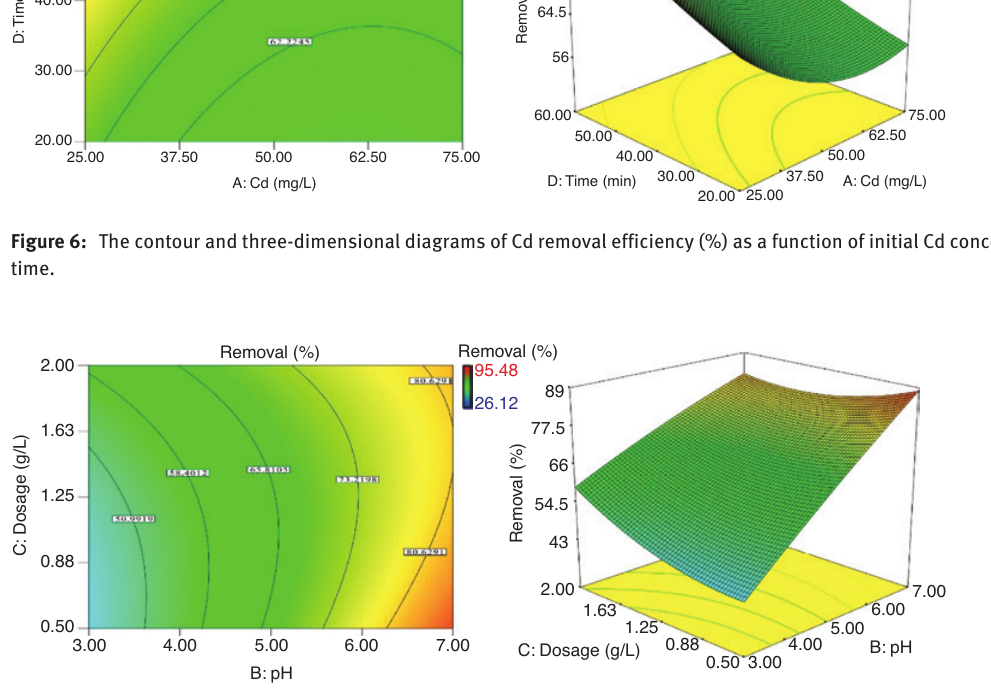
Figure 7: The contour and three-dimensional diagrams of Cd removal efficiency (%) as a function of pH and adsorbent